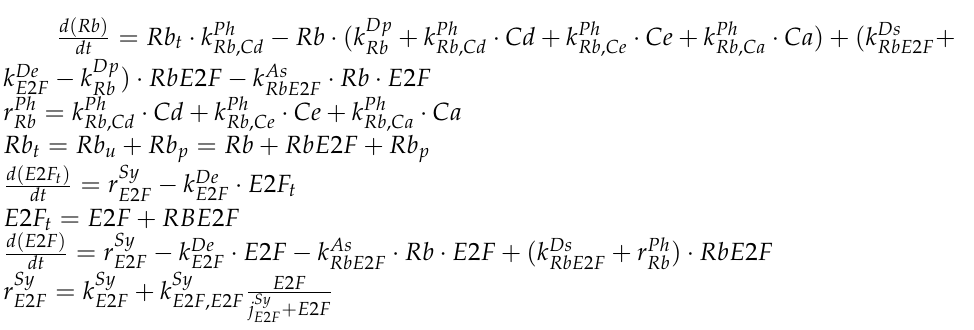
Figure S17. Sensitivity analysis for the 22 parameters, which control the interaction between regulators, on